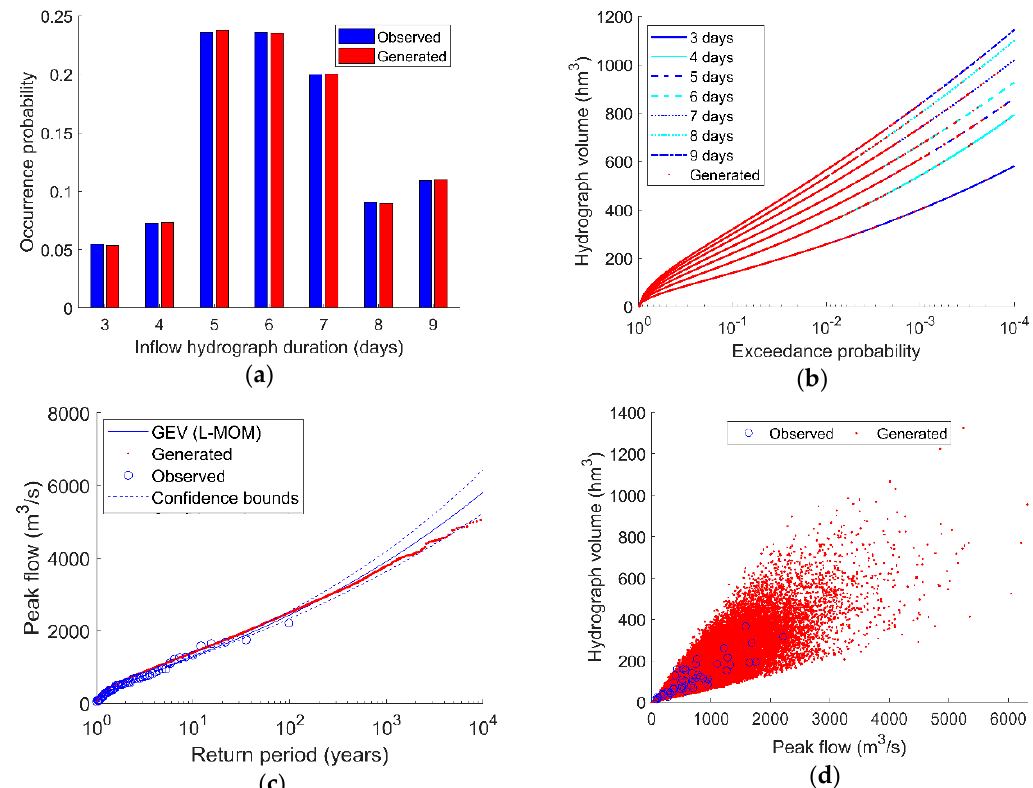
Figure 2. Synthetic inflow hydrograph generation. ( a ) Frequency distribution of the observed (blue) and simulated (red) reservoir inflow hydrograph duration ( b ) Generalized Extreme Value (GEV) distribution fits using the L-Moments (L-MOM) technique of maximum annual hydrograph volume for the different observed durations (blue lines) and the simulated volumes (red dots). ( c ) GEV fits using the L-Moments (L-MOM) technique of the maximum annual instantaneous peak flows. Blue circles represent the maximum annual instantaneous peak flow with return periods obtained by applying the Gringorten plotting position formula, blue continuous line represents the GEV L-MOM fit, blue dashed lines represent the 99% confidence bounds, whereas the red dots represent the maximum peak flows generated with a return period obtained by applying the Gringorten plotting position formula. ( d ) Sample of 100,000 simulated floods (red dots) plotted with the observed floods (blue-edged circles).